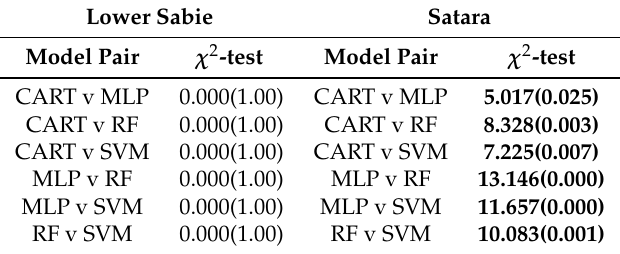
Table A1. Two-proportions Z-test comparing the proportions of estimated grazing lawn cover. Values in parenthesis represent p -value. Model pairs that show statistically significant difference ( p ≤ 0.05) in proportion of grazing lawn cover are in bold. CART = Classification and Regression